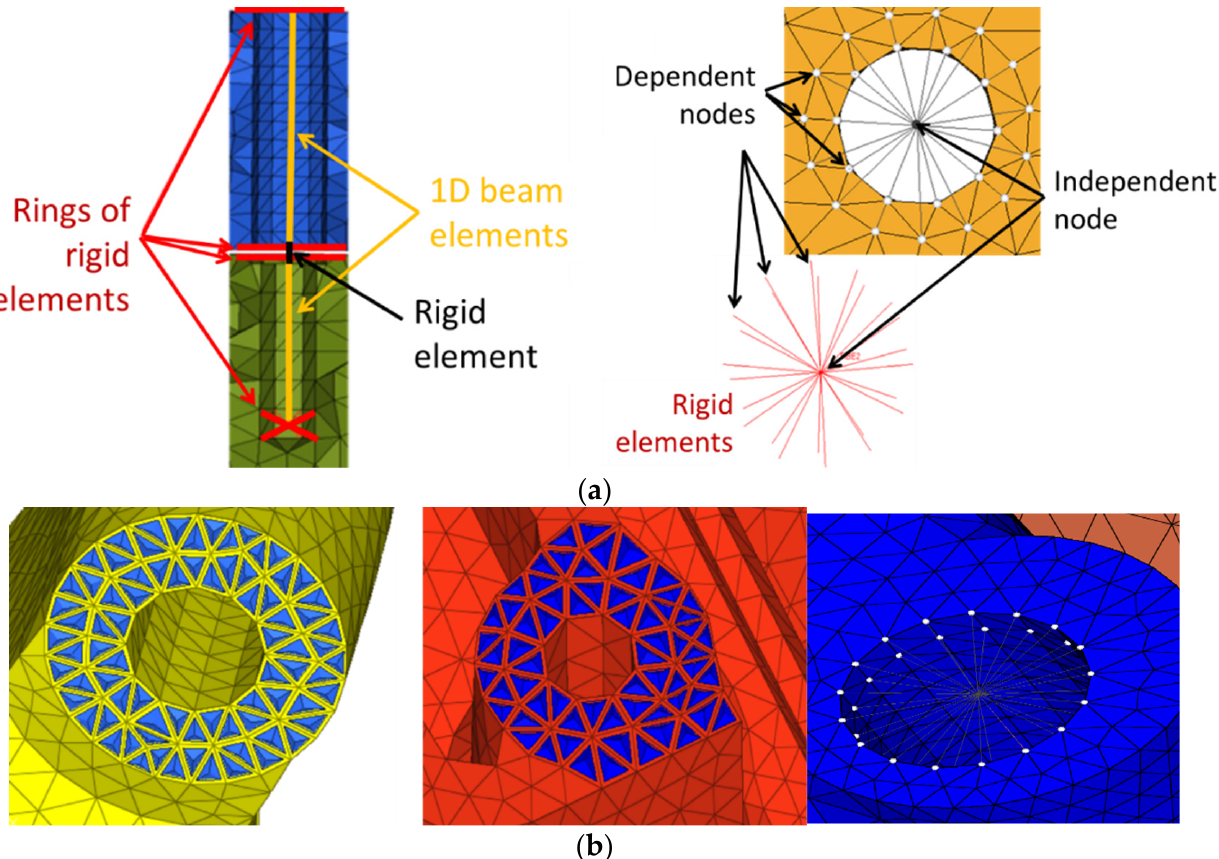
Figure 6. ( a ) 1D simplified approach with rigid and elastic beam elements; ( b ) approach with “Glue surfaces”, with highlight of contact continuity conditions ( left - center ) and star of rigid elements ( right ).